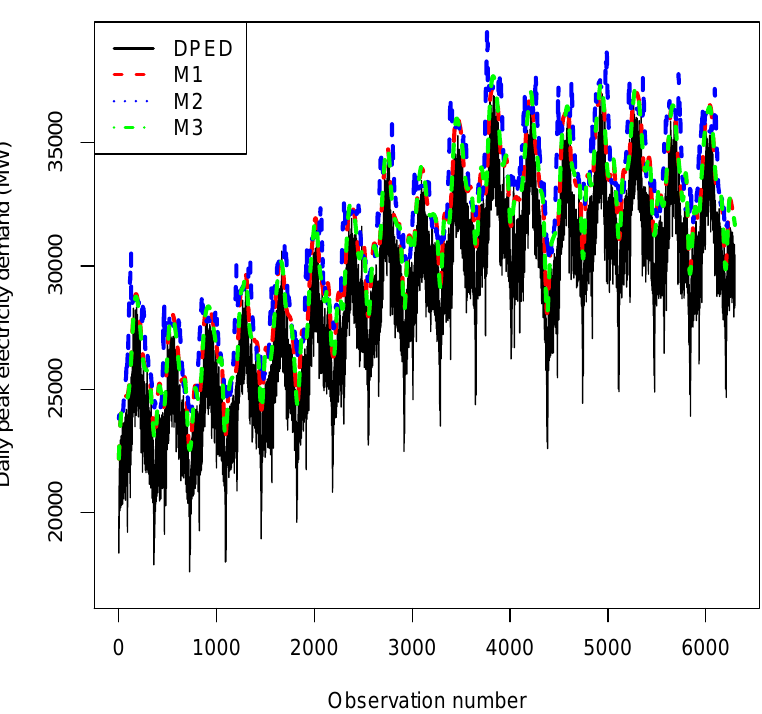
Figure 4. DPED superimposed with the 0.99 quantiles from the M1, M2 and M3 models.